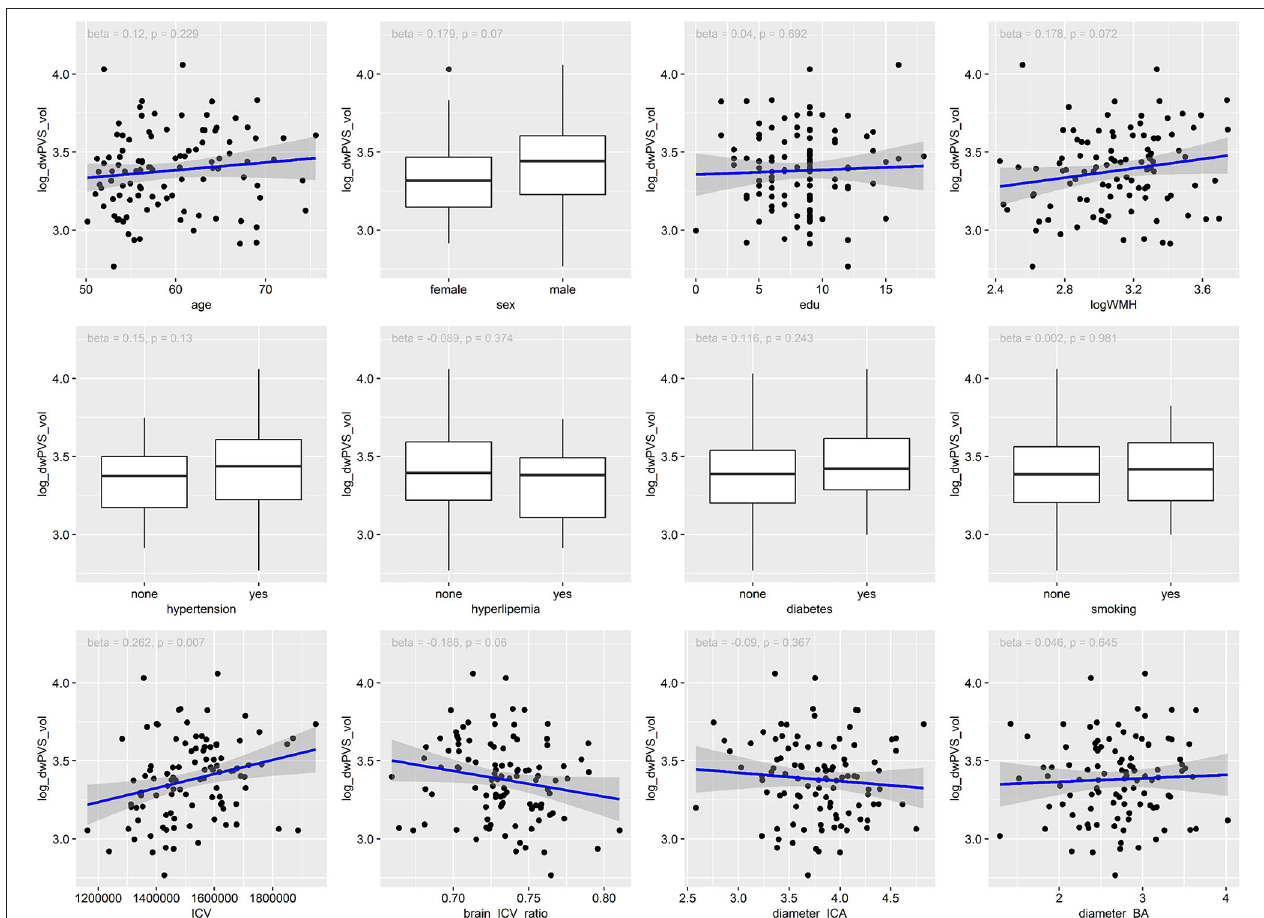
FIGURE 3 | Association between risk factors and the volume of dwPVS.